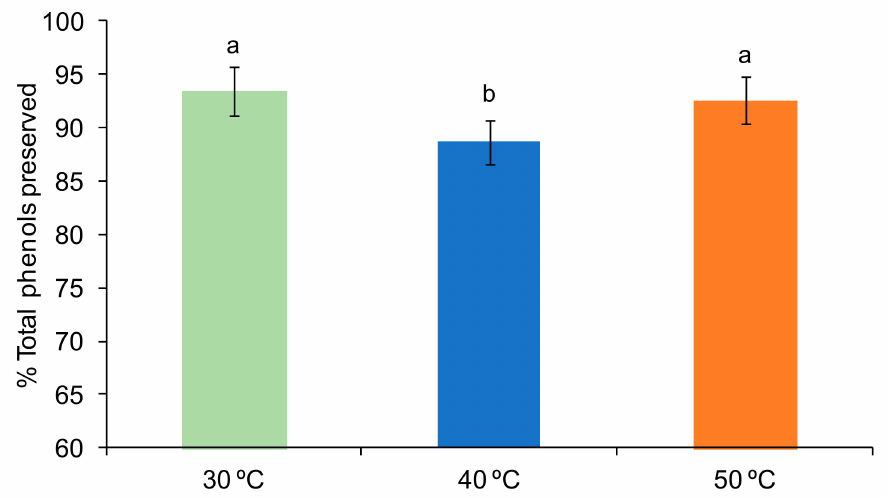
Figure 4. Percentage (%) of preserved total phenols (mean and Tukey’s HSD) of samples according to the shelf temperature factor (30, 40 or 50 ◦ C). Di ff erent letters indicate di ff erent homogeneous groups for the shelf temperature factor ( p < 0.05). Data of both freezing rates and both pressures are considered in the mean